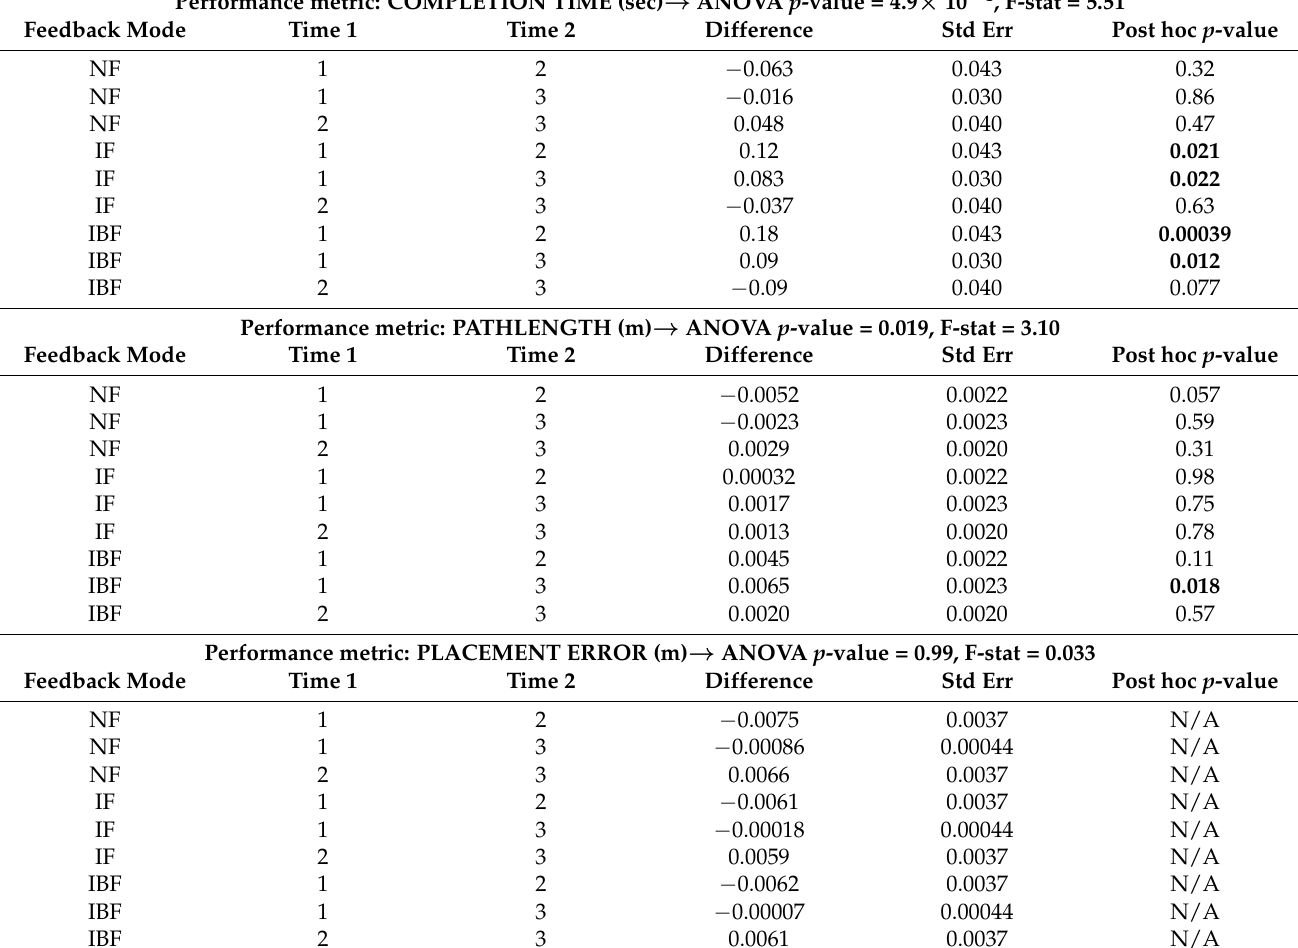
Table 3. Repeated measures ANOVA across trial-block times (pre-training, training, post-training) for each performance metric and training condition (feedback mode); Trial-Block Time Indices: 1 = Pre-training, 2 = Training, 3 = Post-training; Feedback Modes: NF = No Feedback, IF = Immediate Feedback, IBF = Intentional Binding Feedback; ‘Difference’ is computed from performance metric value for Time 1 – Time